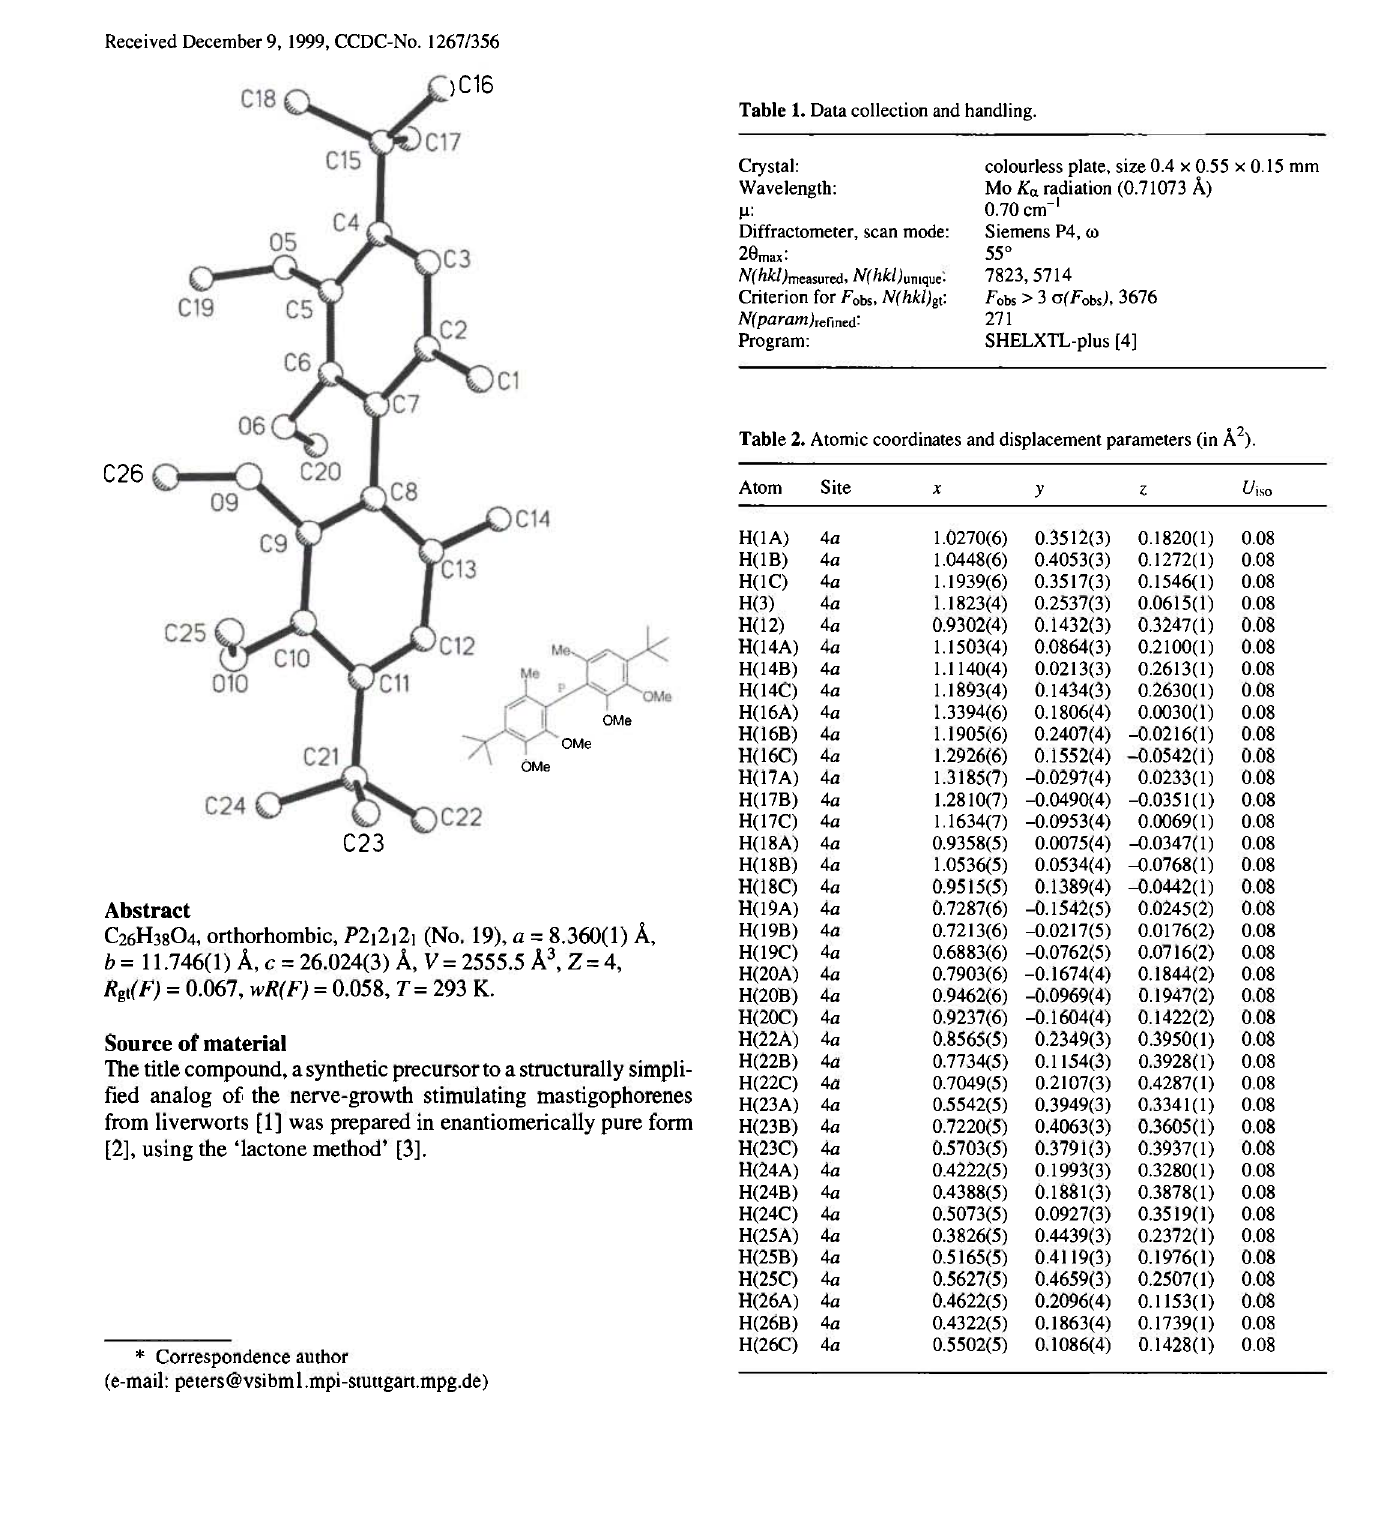
Table 1. Data collection and handling.